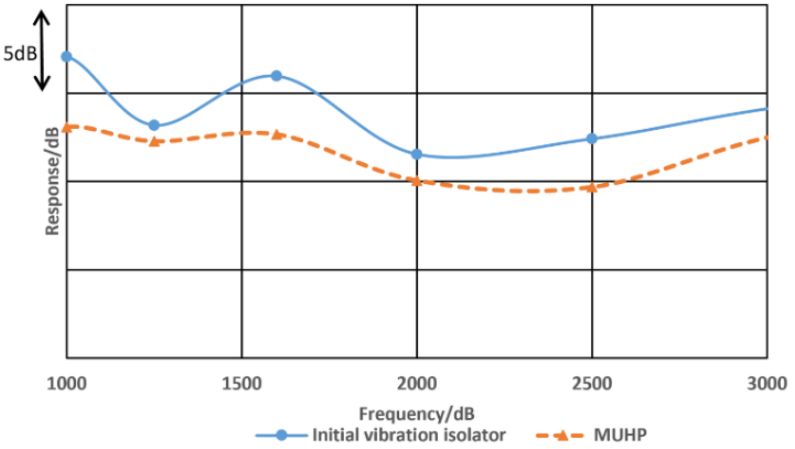
Figure 11. The housing response when two types of vibration isolators were installed.